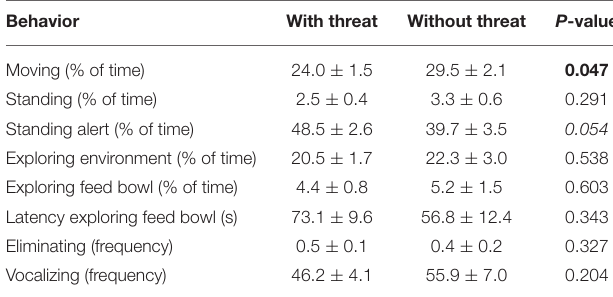
TABLE 8 | Behavior performed in the attention bias test with or without receiving a threat. Behavior With threat Without